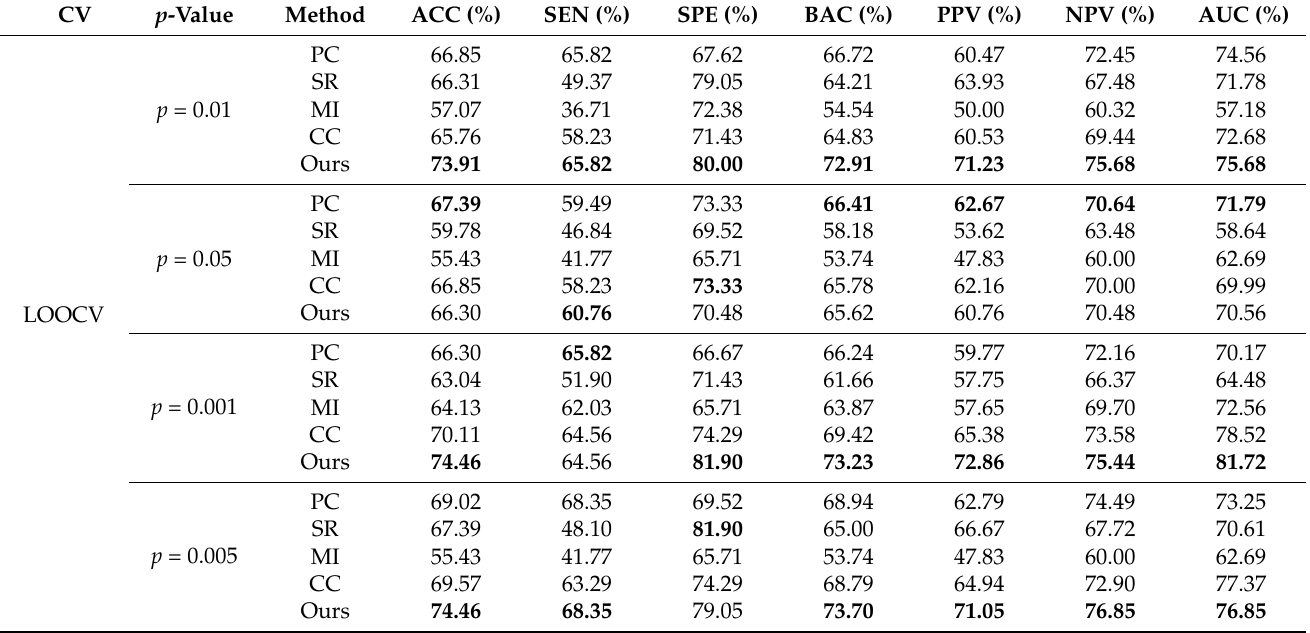
Table 4. Classification results (mean ± standard deviation) of the proposed method and four single- view methods (i.e., PC, SR, MI, and CC) based on different p -values involved in the t -test. CV: cross validation.